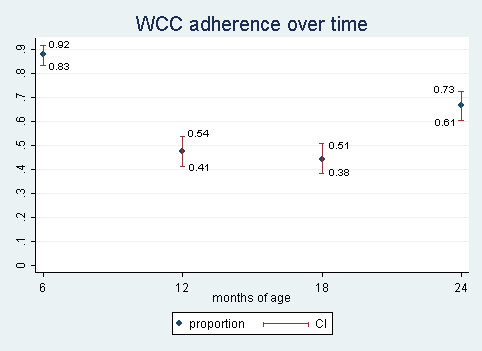
Well child care adherence by age.